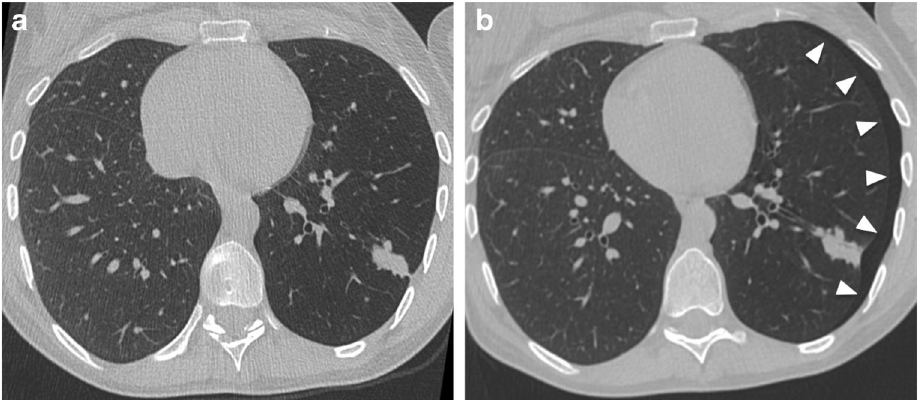
Fig. 7 CT-guided chest biopsy of solitary pulmonary nodule in the left lower lobe. (a) Axial CT image before the procedure showing the subpleural nodule. (b) Post-procedural axial CT image showing small PNX (arrows) as a complication of transthoracic